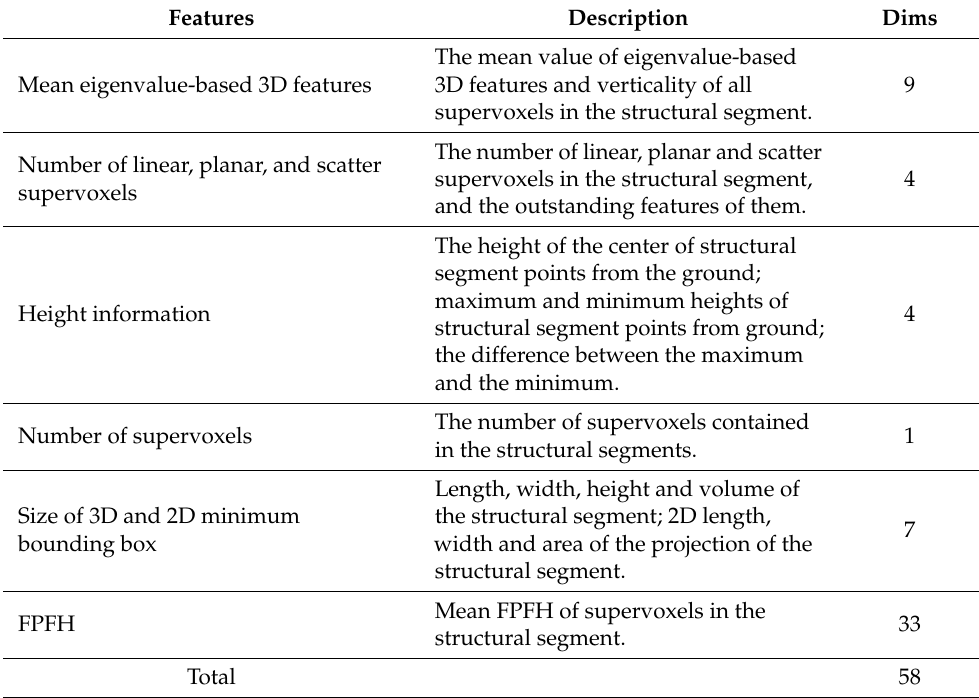
Table 1. Configuration of the input features of RF in this